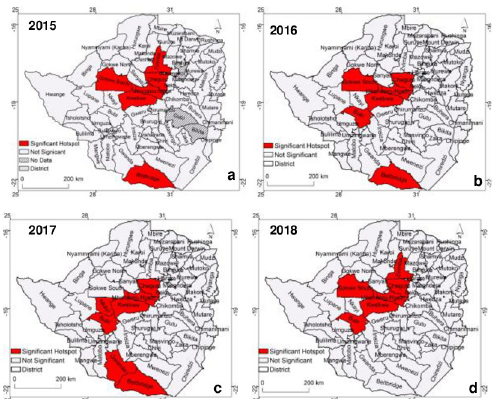
Fig 3. Spatial distribution of TB hotspots in Zimbabwe at district level for (a) 2015, (b) 2016, (c) 2017 and (d)